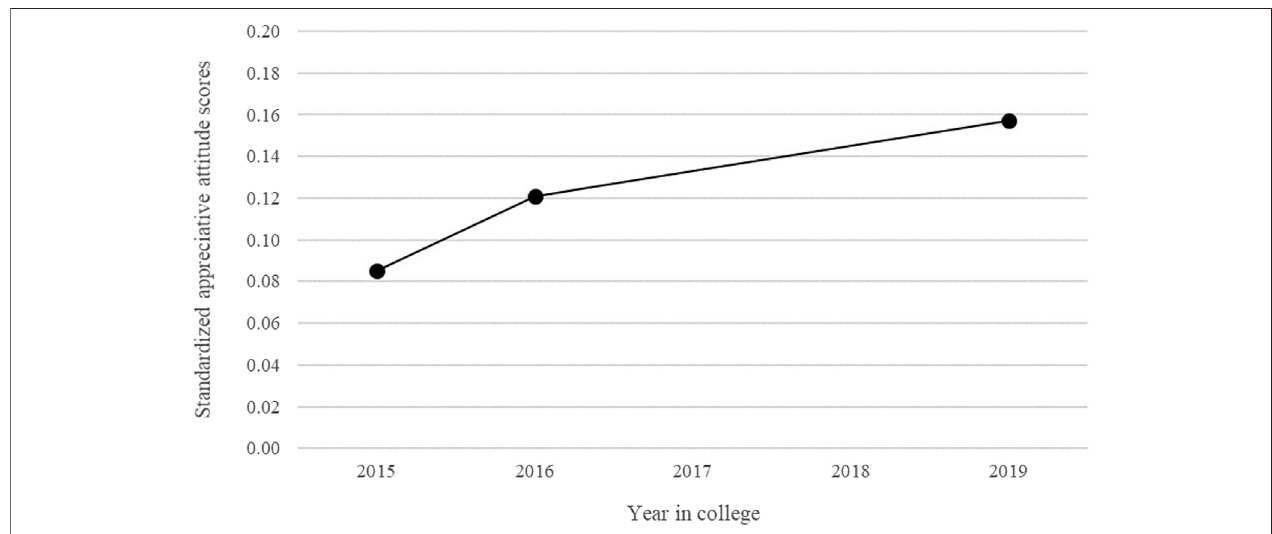
FIGURE 3 | Growth trajectory for standardized appreciative attitudes toward evangelical Christians by